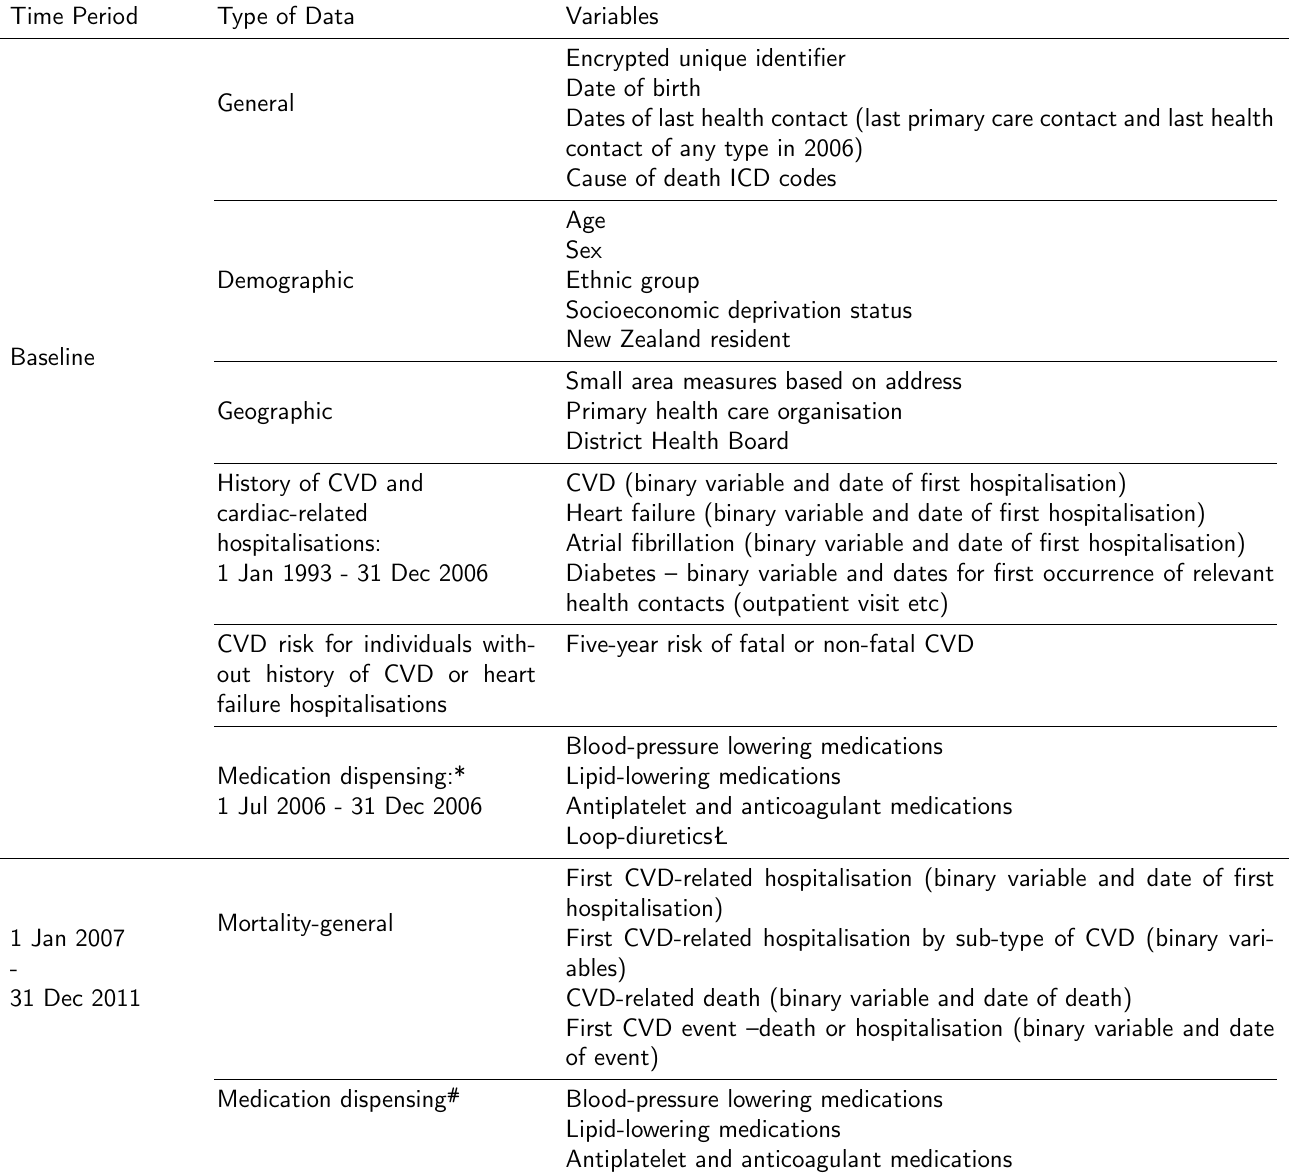
Table 2: Overview of the Vascular Risk of Adult New Zealanders 2006 (VARIANZ 2006) cohort study